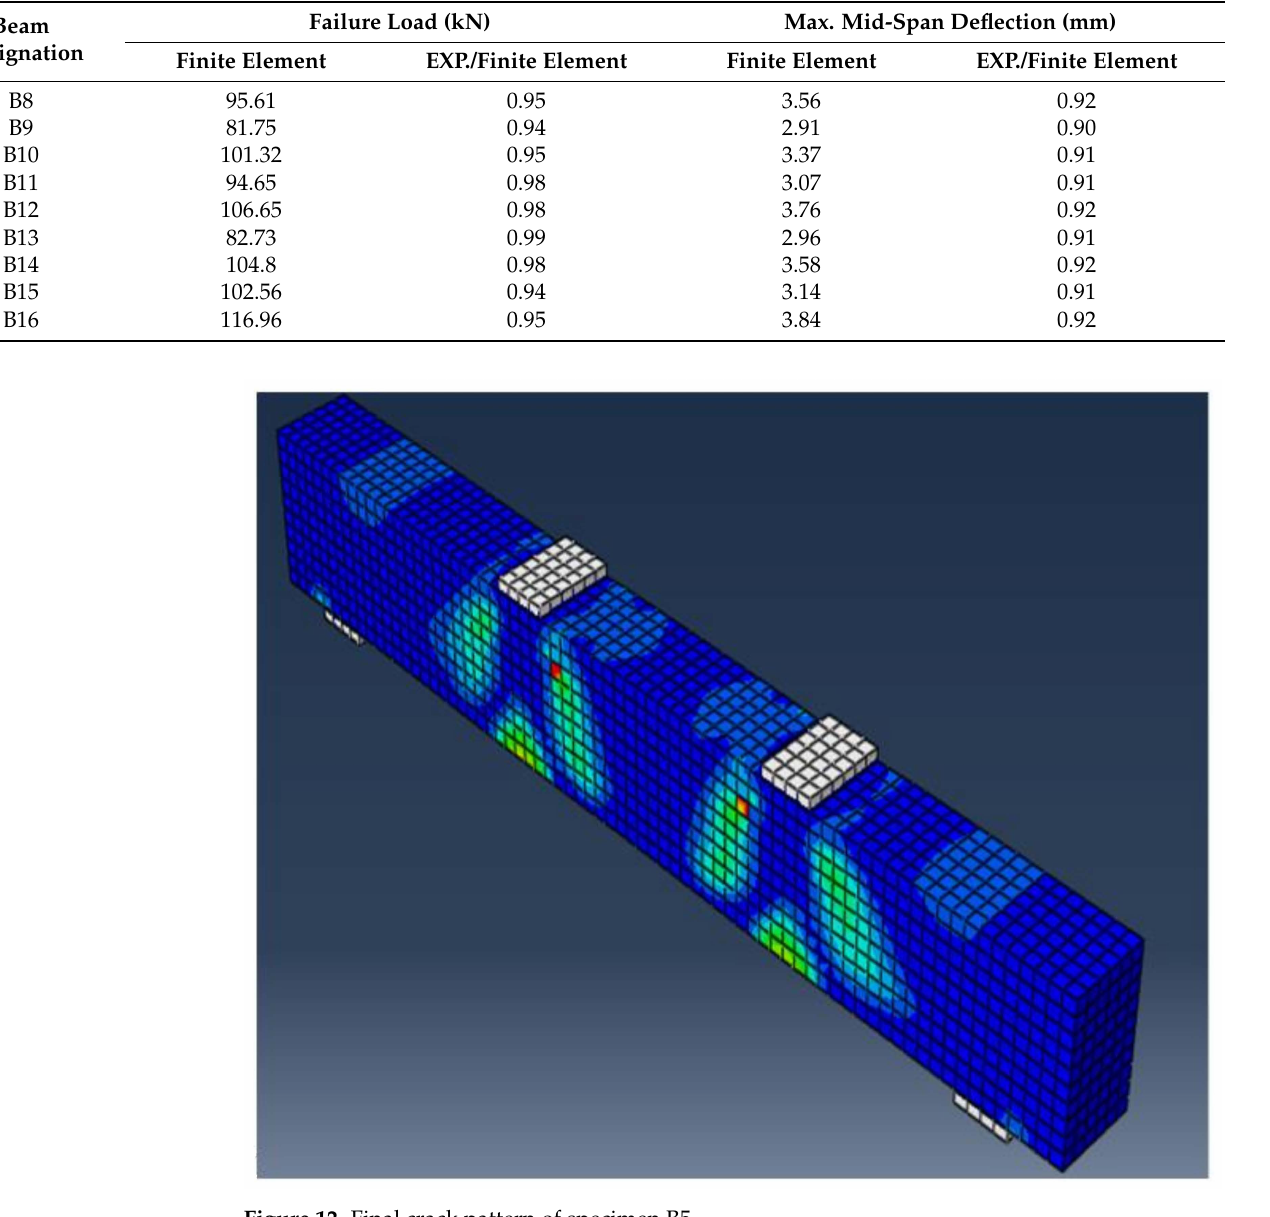
Figure 12. Final crack pattern of specimen